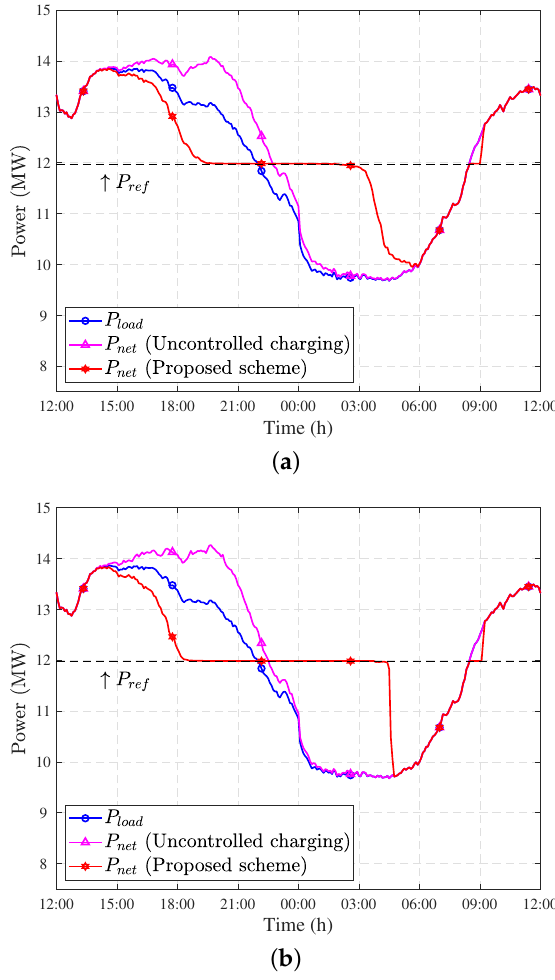
Figure 9. Net load profile of the feeder without EVs, with uncontrolled charging and utilizing the proposed scheme. ( a ) For 3 kW charger rating; ( b ) For 7 kW charger